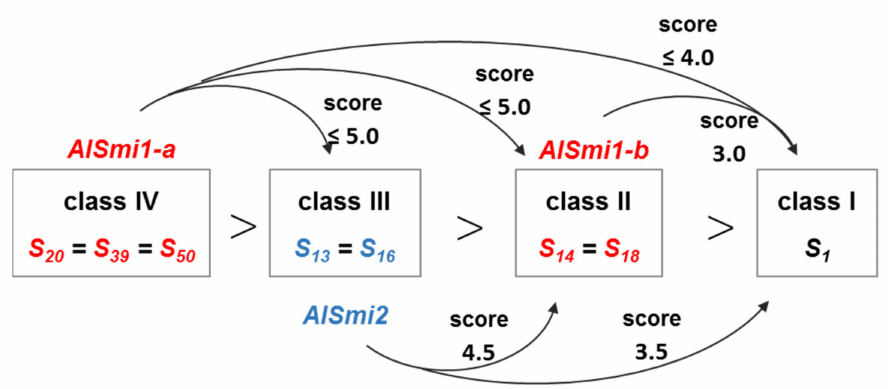
Figure 6. Regulatory network of the identified sRNAs and their predicted targets in A. lyrata. Class- IV S 20 -SP11 is dominant over class-III S 13 -SP11 (Figure 1). AlSmi1-a from class-IV S haplotypes is homologous to SP11 from recessive S haplotypes (classes III, II, and I), showing a mispair score < 5.0 (Figure 2). AlSmi1-b predicted from class-II S haplotypes is homologous to a class-I SP11 , showing a mispair score < 3.0 (Figure 3). AlSmi2 from class-III S haplotypes is homologous to SP11 from relatively recessive S haplotypes (classes II and I), showing a mispair score < 4.5 (Figure 4). Both precursors and mature 24-nt sRNA of AlSmi1-a and AlSmi2 were detected in vivo (Figure 5). AlSmi1 and AlSmi2 correspond to mirS3 and mir1887 in A. halleri , respectively [9].